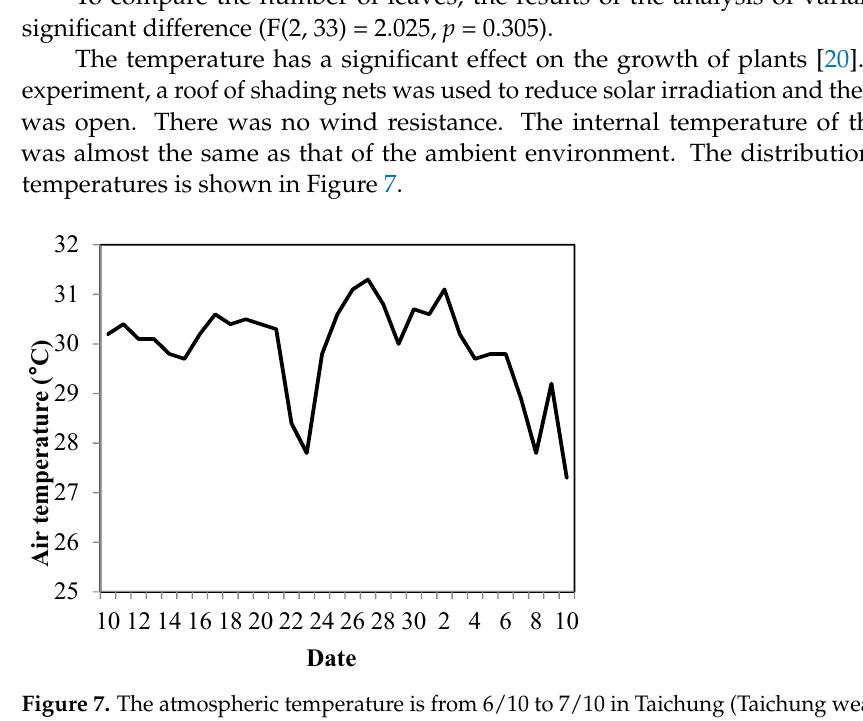
Figure 7. The atmospheric temperature is from 6/10 to 7/10 in Taichung (Taichung weather stations). Pak choi grows well between 20 and 25 ◦ C. During this experimental period, the daily average temperature of the outdoor group was 28.6 ◦ C, and the highest average temperature was 33.4 ◦ C. At this time, the external environment at the experimental site was no longer suitable for the growth of Pak choi, so the growth conditions for the net house group were lower than those for the high oscillation temperature group. The fresh weight of the roots is also affected by the high temperature in the soil, which promotes the growth and development of roots, so the fresh weight of the roots is greatest for the net house group.